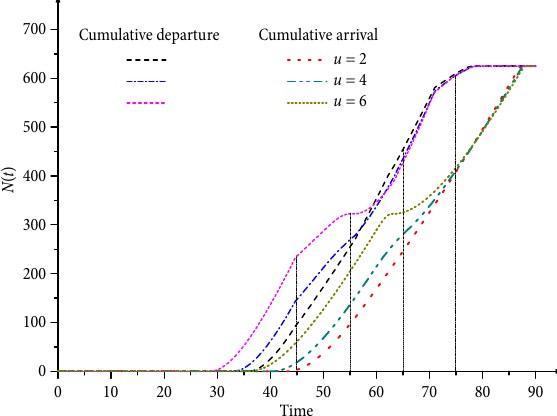
Fig. 11. Cumulative N -curves for the third type of toll profiles